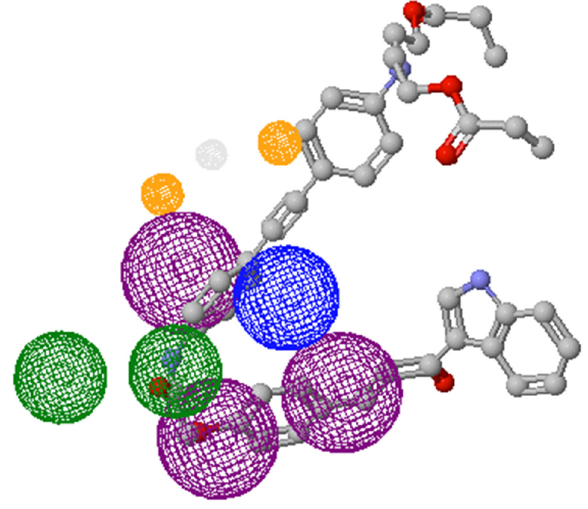
Figure 7. Indole-acetylene derivative 15 into the SARS-CoV-2-Mpro pharmacophore model. Blue spheres are the aromatic segments (Ar), green spheres depict the hydrophobic segments (Hy), gray spheres depict the hydrogen donor segments (HD), orange spheres represent the hydrogen acceptor segments (HA), and purple spheres represent the hydrophobic and aromatic segments (Hy–Ar).